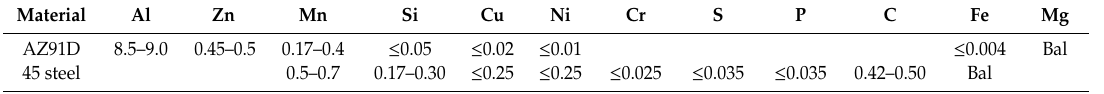
Table 1. Chemical composition (wt.%) of the materials used in this